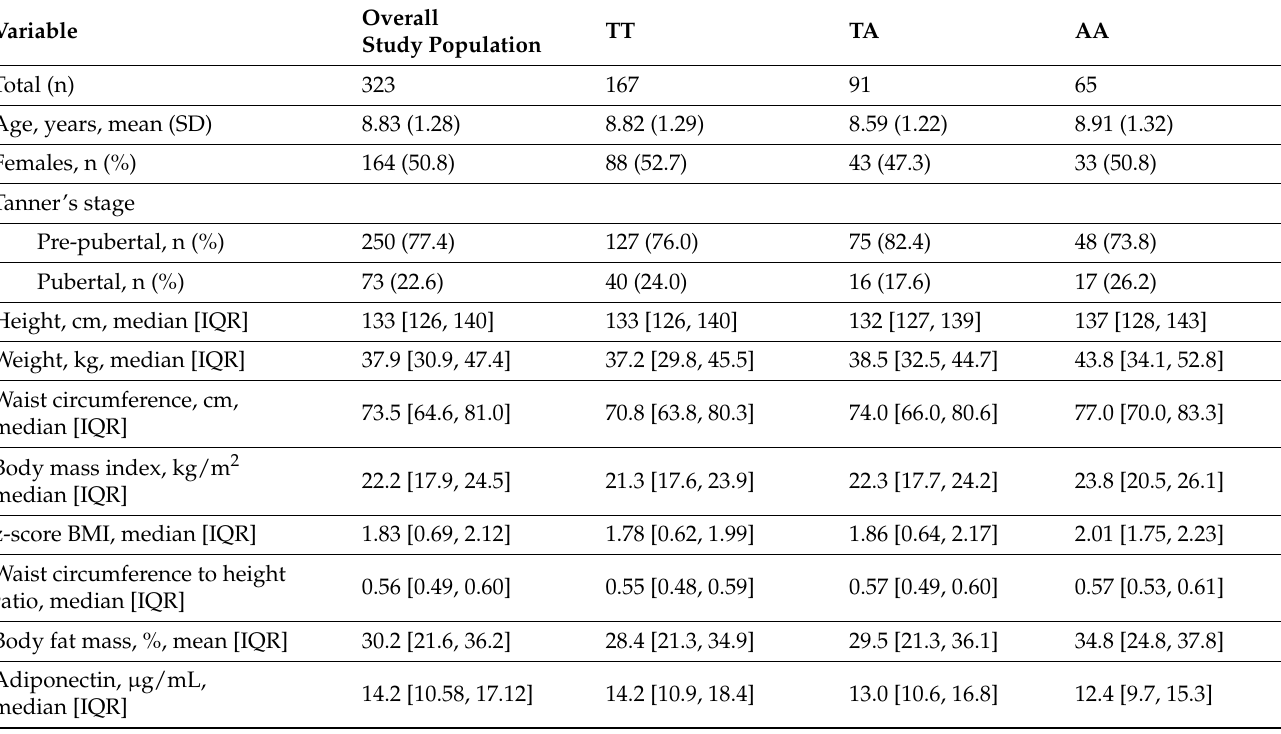
Table 1. Characteristics of the study